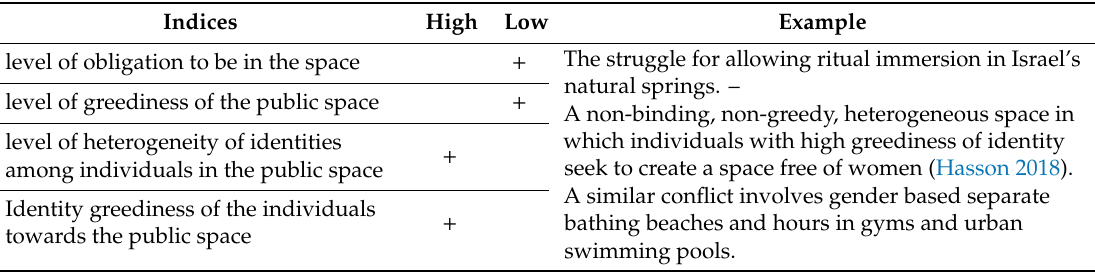
Table A15. Medium potential confrontation.